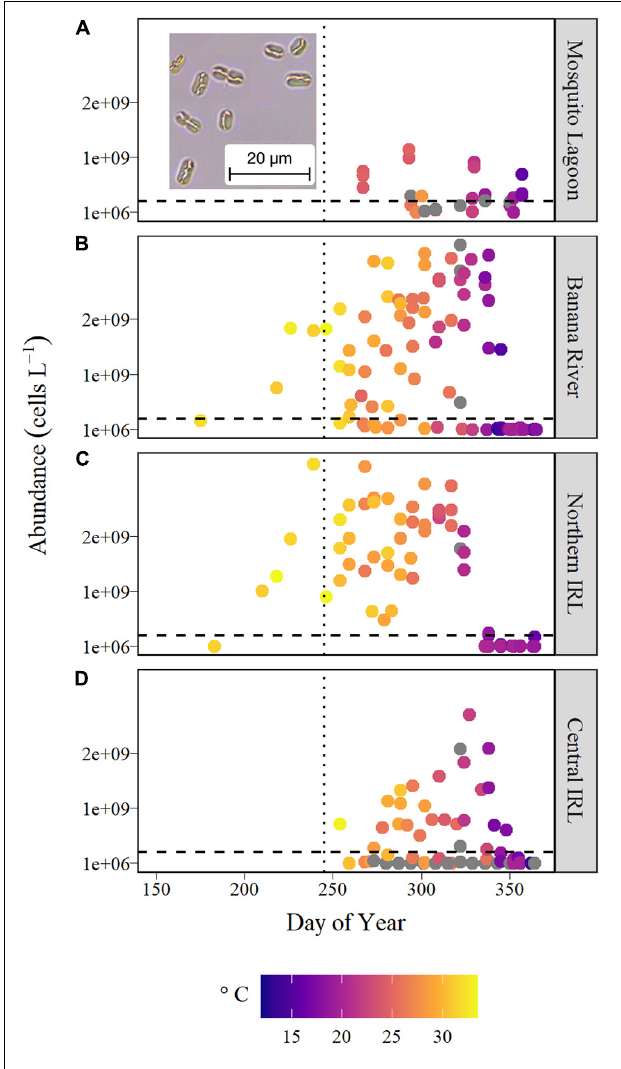
FIGURE 8 | Cell abundance of the novel cyanobacterium shown on a linear scale for (A) Mosquito Lagoon, (B) Banana River Lagoon, (C) Northern IRL, and (D) Central IRL for June through December 2020. Symbol color indicates temperature recorded at discrete depths of samples, shown as a gradient from the lowest temperature (blue) to the highest (yellow), and gray symbols represent samples in which no discrete temperature was recorded. The dashed horizontal line represents 2 × 10 8 cells L − 1 and the dotted vertical line represents JD 245 (September 1). (Inset) Phase contrast light microscopy image of live cells of the novel cyanobacterium, depicting a refringent structure inside each cell, the aerotope.